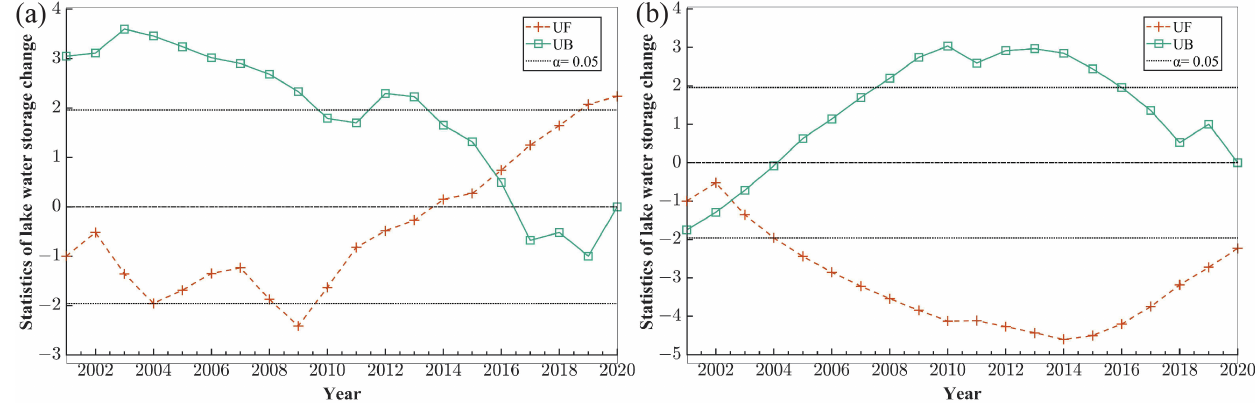
Figure 6. Statistical curve of the MK method test of accumulative lake storage changes ( a ) Ulungur Lake; ( b ) Bosten